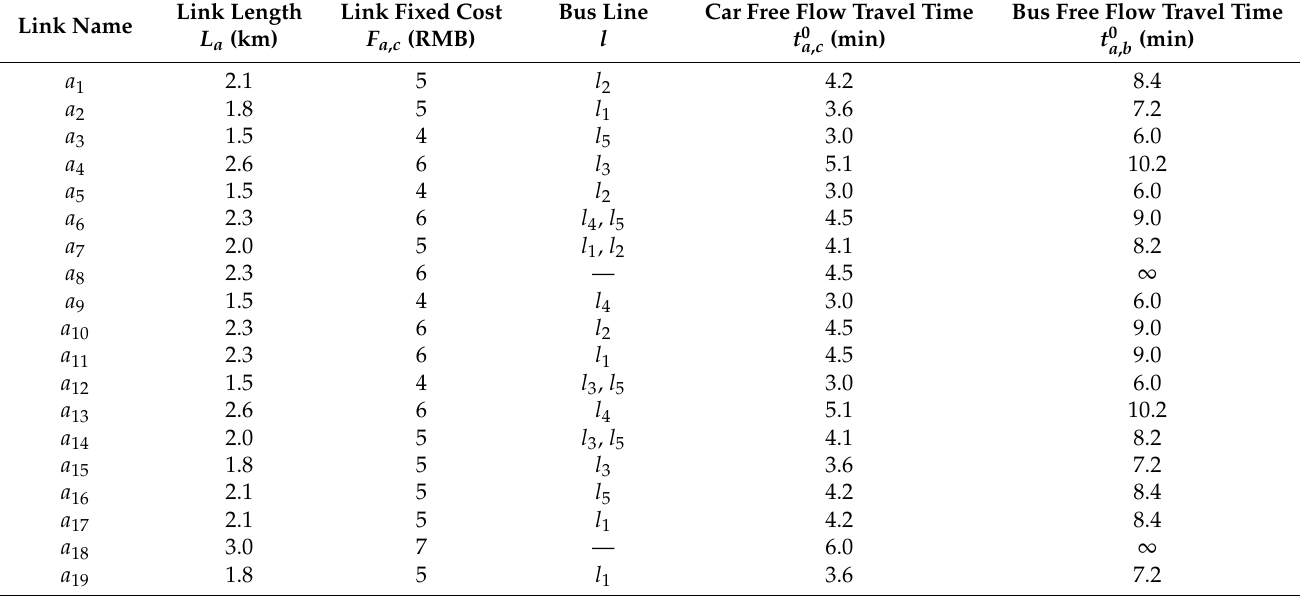
Table 5. Traffic network